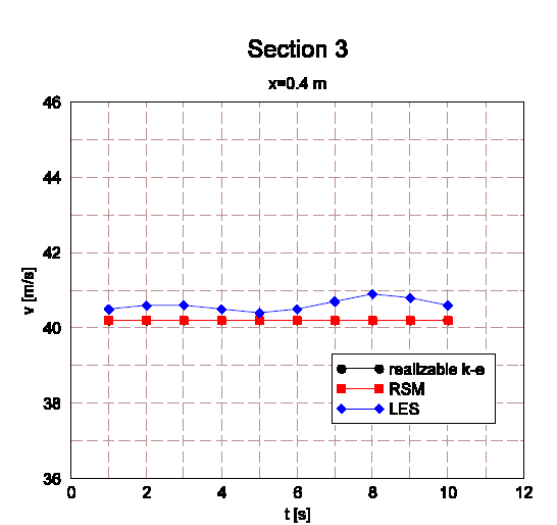
Figure 6. Velocity evolution in time for section 3 for the three turbu- lence